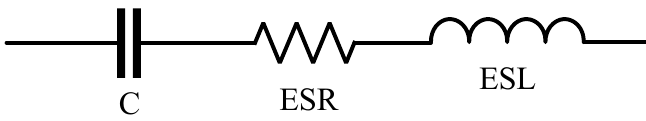
Figure 12. Equivalent circuit of a capacitor.